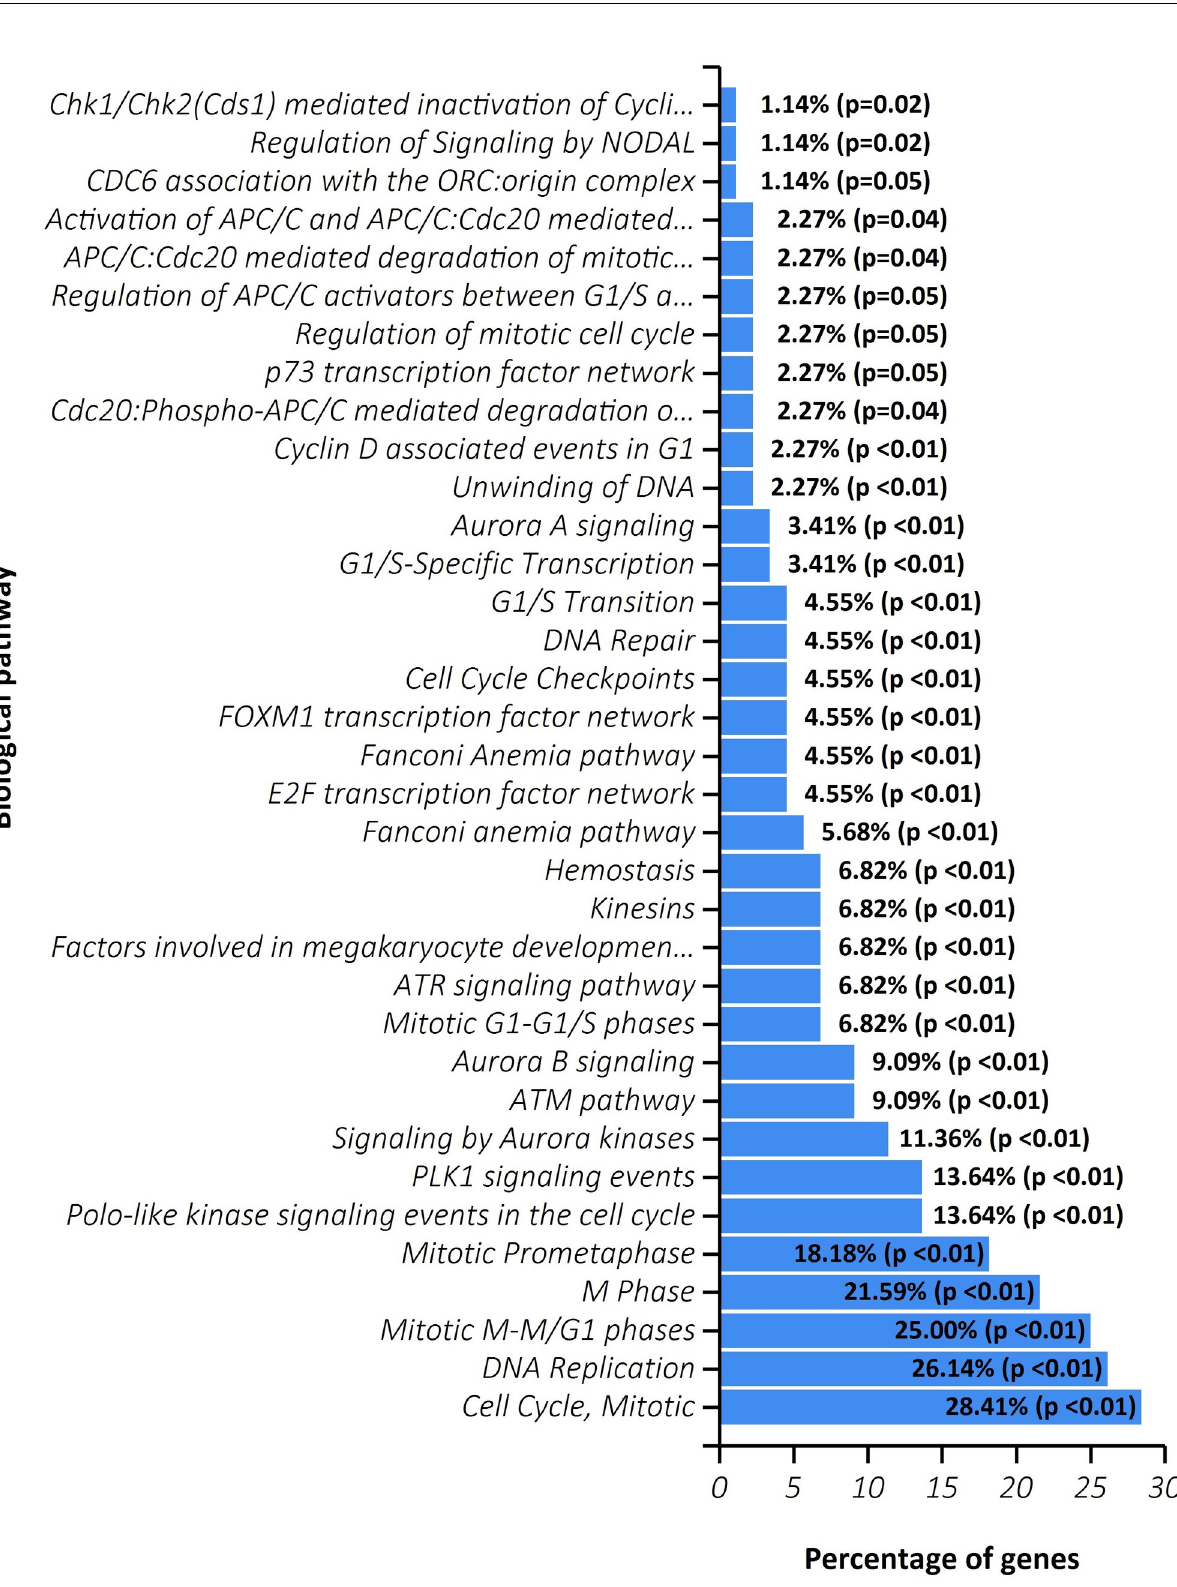
PLOS ONE | https://doi.org/10.1371/journal.pone.0255718 August 9,